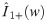
Validation of Eq (44) with the additional term Eq (46).Left: absolute value of I^1+(w) for w∈R, the exact value (solid thick gray line), the approximate value obtained through Eq (44) (gray dash-dot thin line) and the approximate value obtained by adding Eq (46) to Eq (44) (solid thin black line) while substituting the exact expression of V^1d(w) and performing the numerical integration. Right: relative error in log10 scale obtained from the approximate expression of I^1+(w) given by Eq (44) with Eq (46). Test cases are relative to different sets of parameters: on top [Φa,Φb,φo]=[0.7π,0.18¯π,0.1π], on bottom [Φa,Φb,φo]=[0.18¯π,1.2π,0.1π]. We recall that φ = Φa and φ = −Φb are the azimuthal directions of the PEC faces of the wedge and φ = φo is the azimuthal direction of the incident Ez-polarized plane wave.